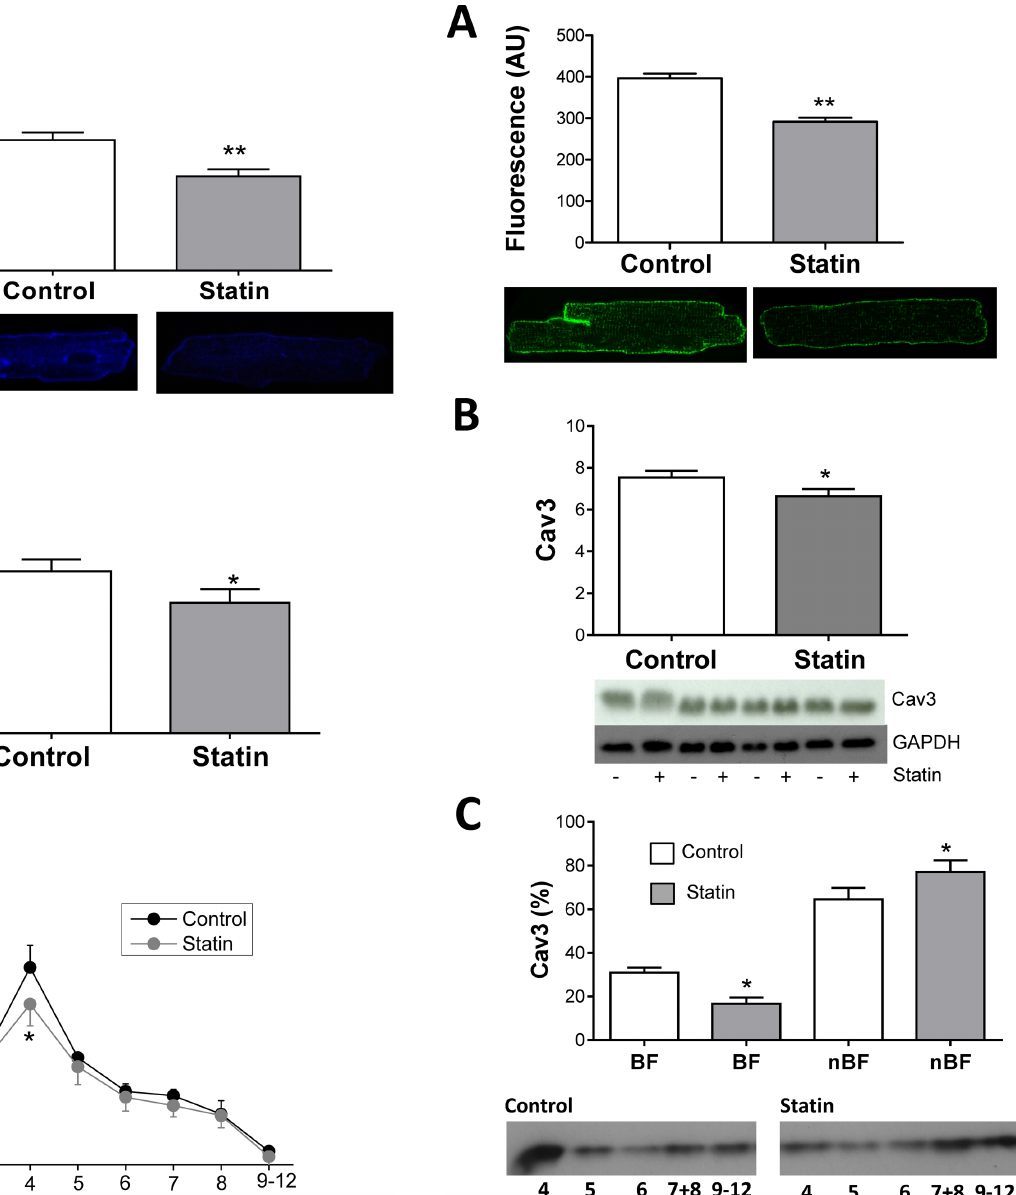
Figure 2. Simvastatin treatment reduces cellular and caveolar Cav3. A. Total membrane-bound Cav3 indexed using immunocyto- chemistry. Bar graph shows mean fluorescence (arbitrary units, AU) from 59–70 myocytes. Representative control and statin-treated myocytes are shown below. B. Total cellular Cav3 measured in cell lysates using Western blotting. Values are normalised to GAPDH. C. Membrane distribution of Cav3 measured in cell lysates following sucrose density gradient fractionation using Western blotting. Fractions 4 and 5 are cholesterol-enriched buoyant fractions (BF); fractions 7–12 are non-buoyant fractions (nBF). All data are mean + S.E.M from n=3–4 hearts. * P , 0.05, ** P , 0.01 vs. control, Student’s t-test.